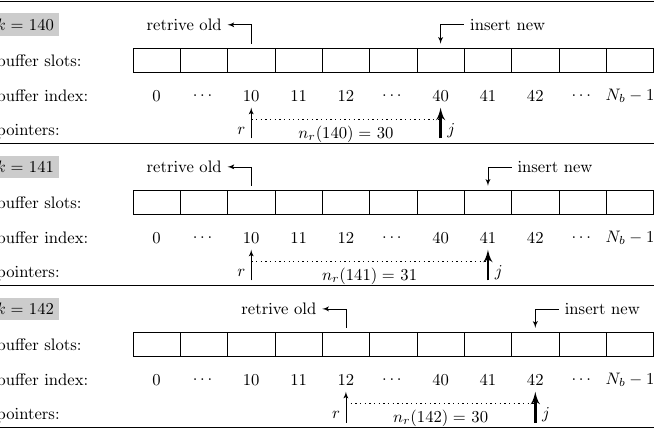
Figure 2. Inner workings of a LVTD. A double decumulation happens at k = 141 due to a frequency decrease. A missed decumulation happens at k = 142 due to a frequency increase. The circular buffer length is N b =